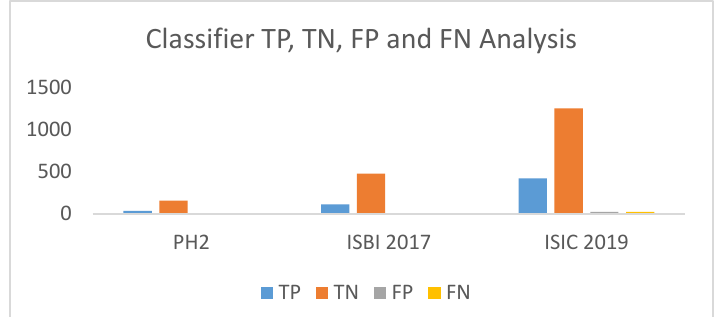
Figure 17. TP, TN, FP, FN analysis of the proposed classifier.